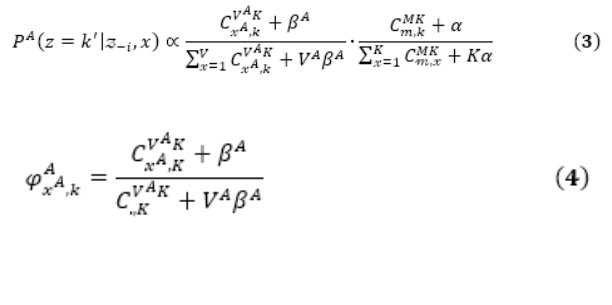
Table 2. Notations of the multiview latent Dirichlet allocation model in Gibbs